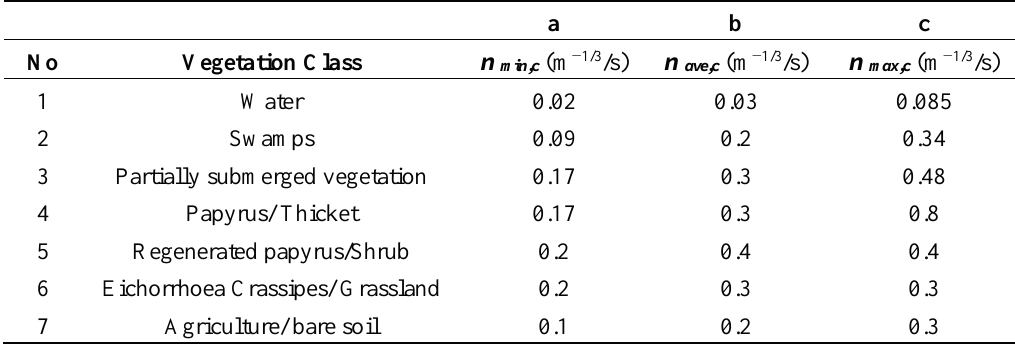
Table 3. Manning’s roughness ranges for different vegetation classes referred from Chow [15] and O’Brien